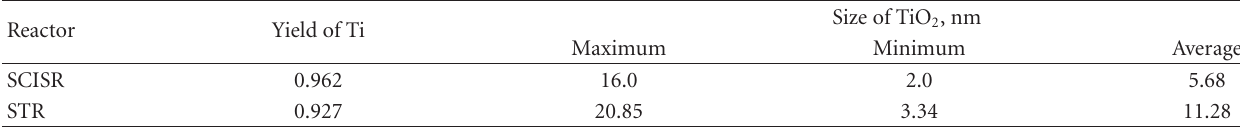
Table 6: Comparative results of SCISR with